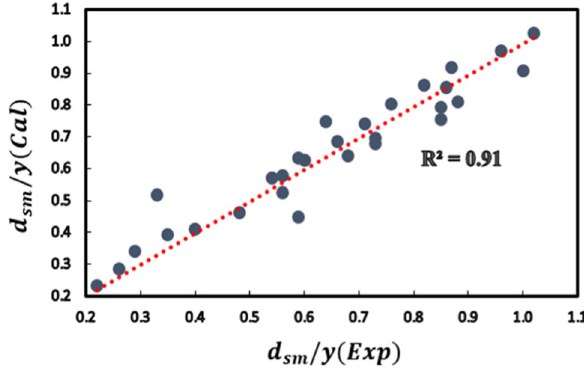
Fig. 6 Comparison between the experimental data and the values obtained from Eq.